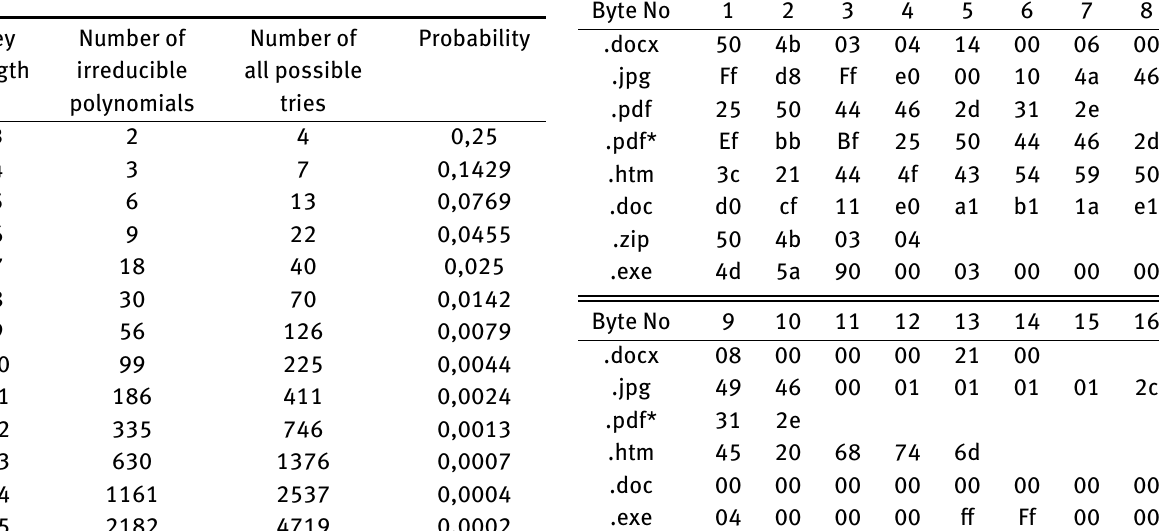
Table 3: Beginnings of files for some standard extension